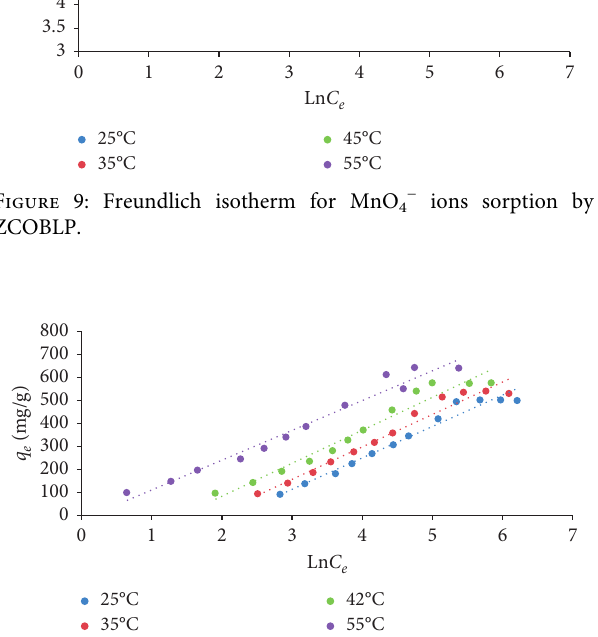
Figure 10: Temkin isotherm for MnO